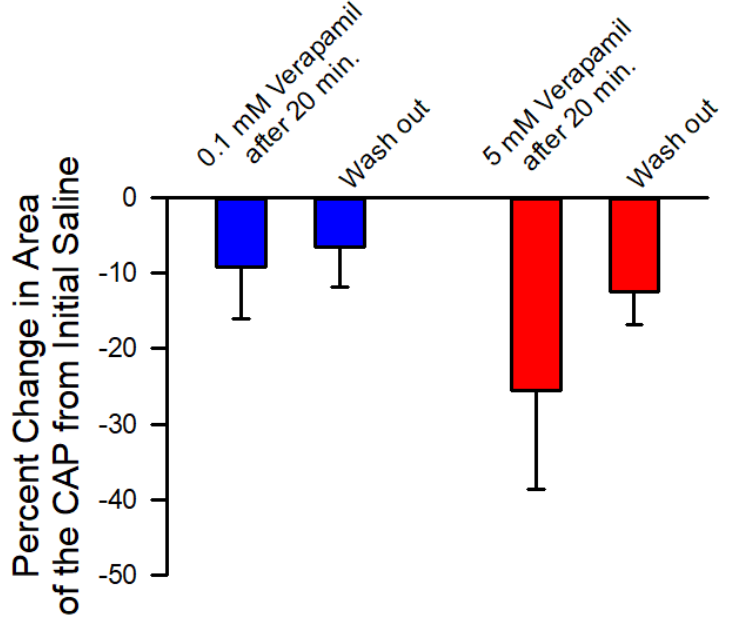
Figure 11. The percent change in the areas of the trace for the compound action potentials (CAPs) in saline and after 20 min of exposure to 0.1 mM or 5 mM of verapamil. The percent change in the area of the CAPs from initial saline to the wash-out is also shown. Some depression still occurred even after washout for both concentrations. ( p < 0.05; paired T-Test; N = 6 for each concentration from initial saline to after 20 min of exposure to verapamil).